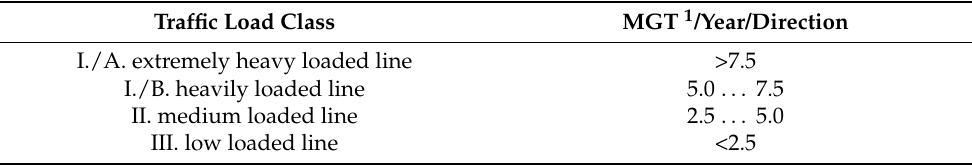
Table 1. Traffic load classes in the case of Budapest’s tramway lines [71].